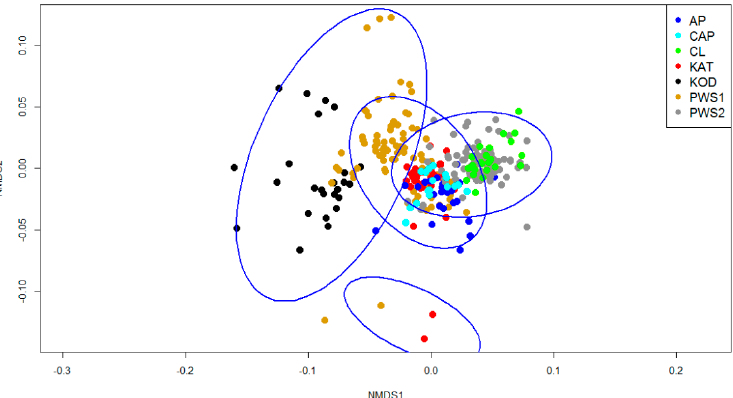
Figure 3. Multivariate, nonparametric, multi ‐ dimensional scaling (NMDS) with cluster analysis of gene transcription profiles (see Table 2) of sea otters sampled at the Alaska Peninsula (AP), Katmai (KAT), Kodiak (KOD), Clam Lagoon (CL), western Prince William Sound 2006, 2007 and 2008 (PWS1), western Prince William Sound 2010 and 2012 (PWS2) and clinically normal captive otters (CAP).